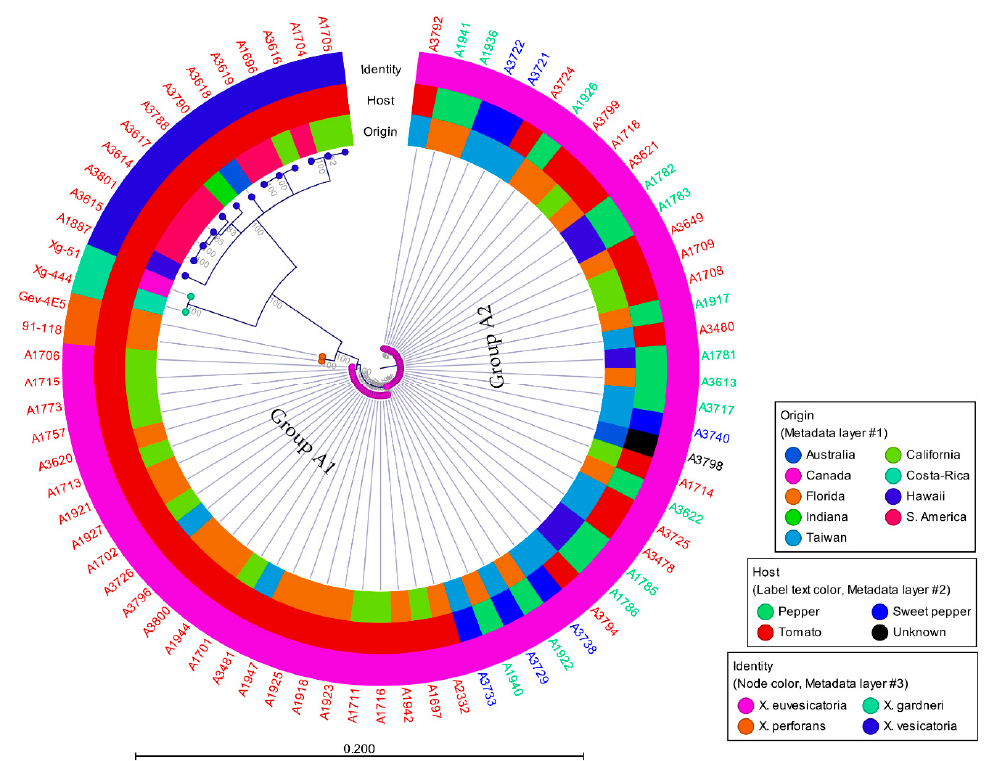
Figure S7. Microorganisms 2019 , 7 , 462